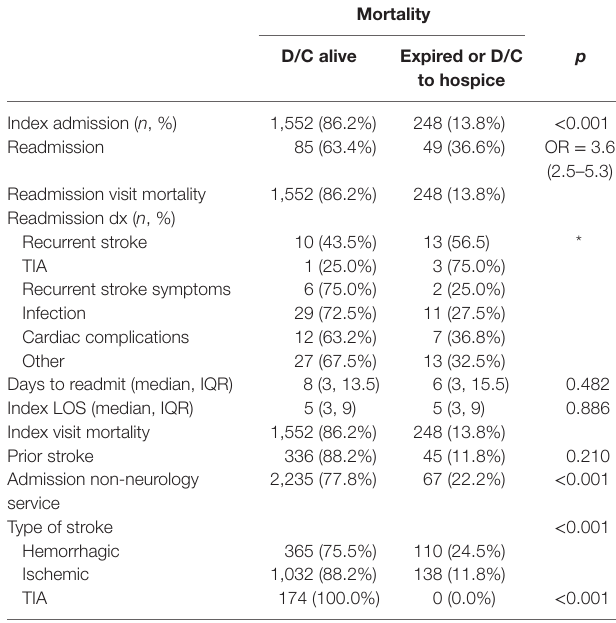
TaBle 3 | Mortality—index and readmission visits.